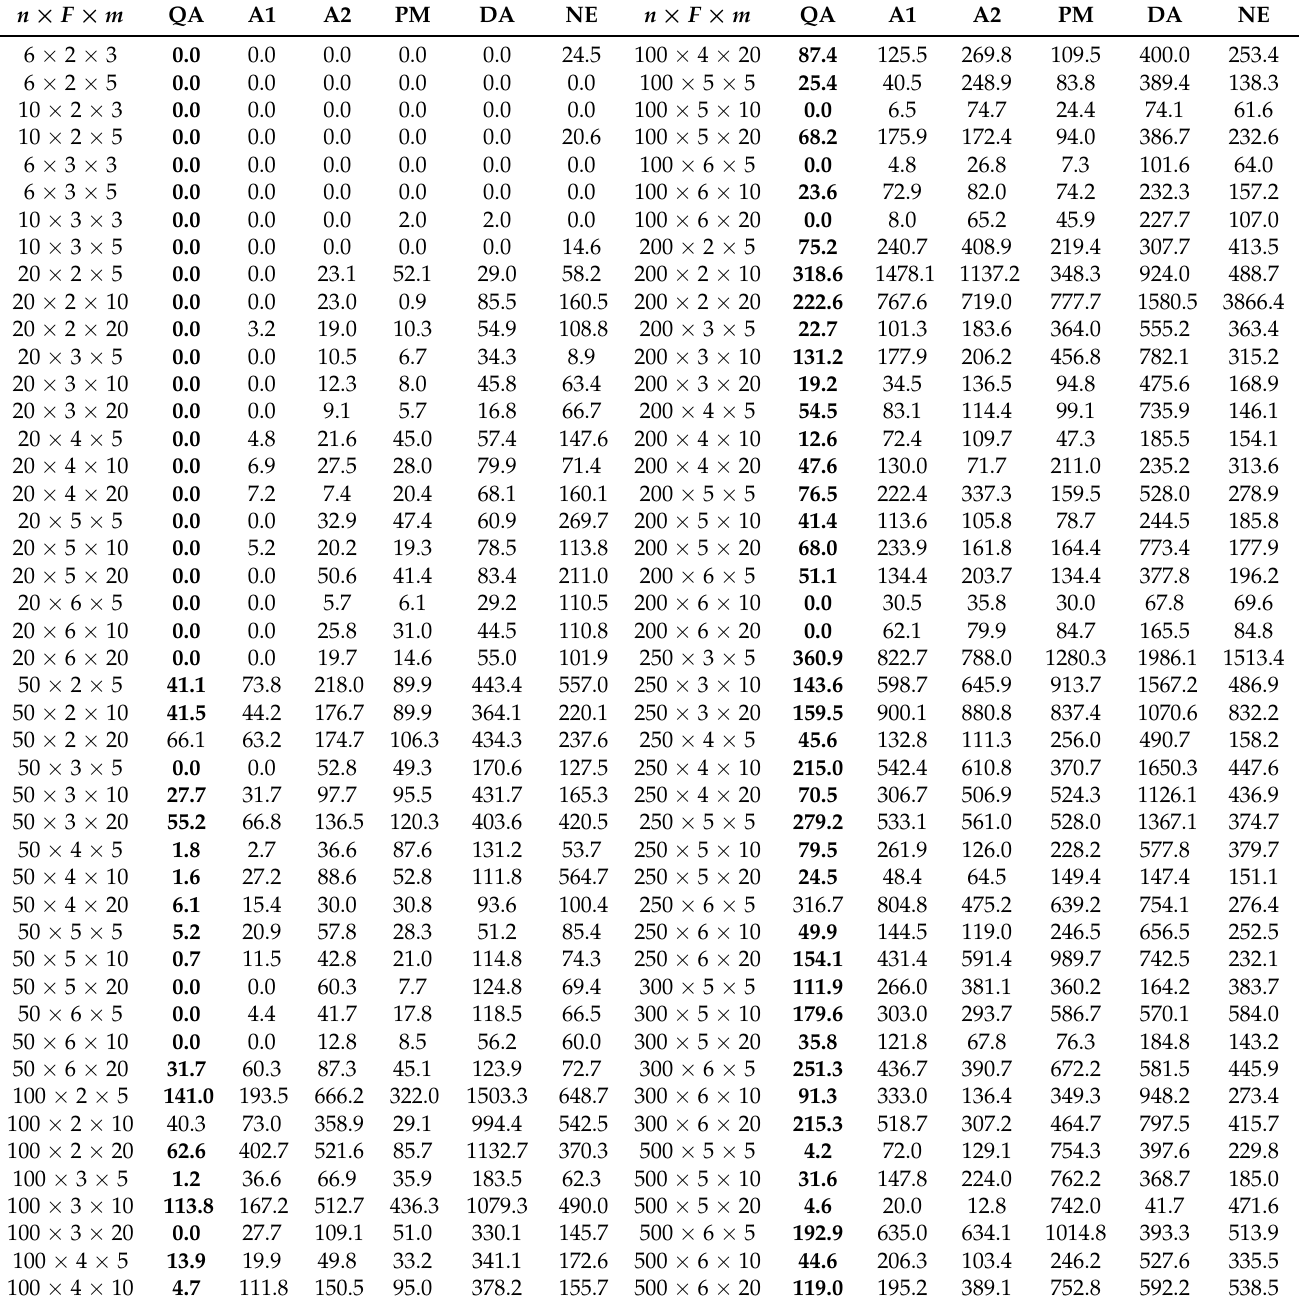
Table 8. Computational results of STD by six